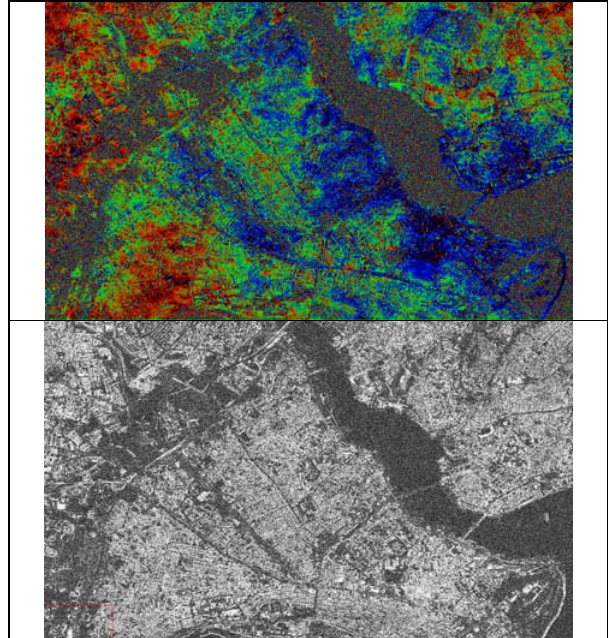
Figure 6.a. Filtered interferogram and coherence map – TSX